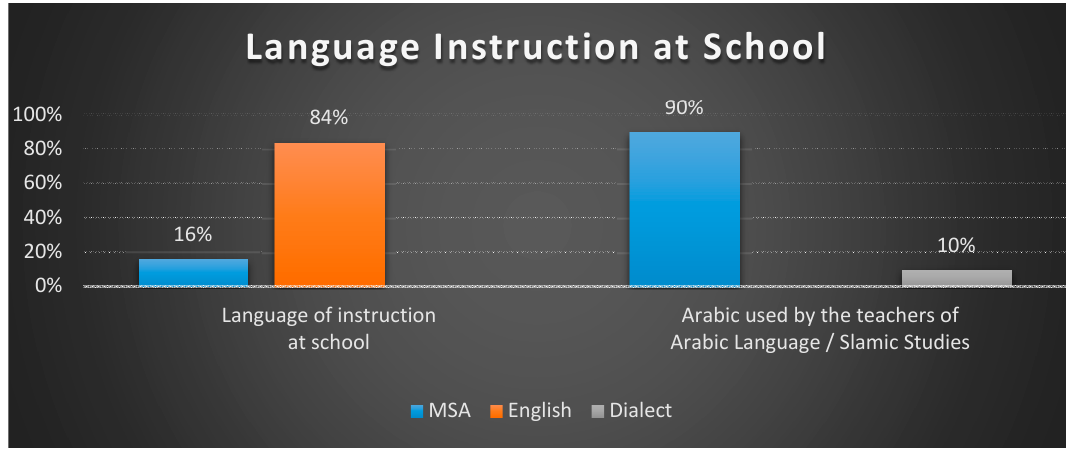
Figure 3. Language of Instruction at School.